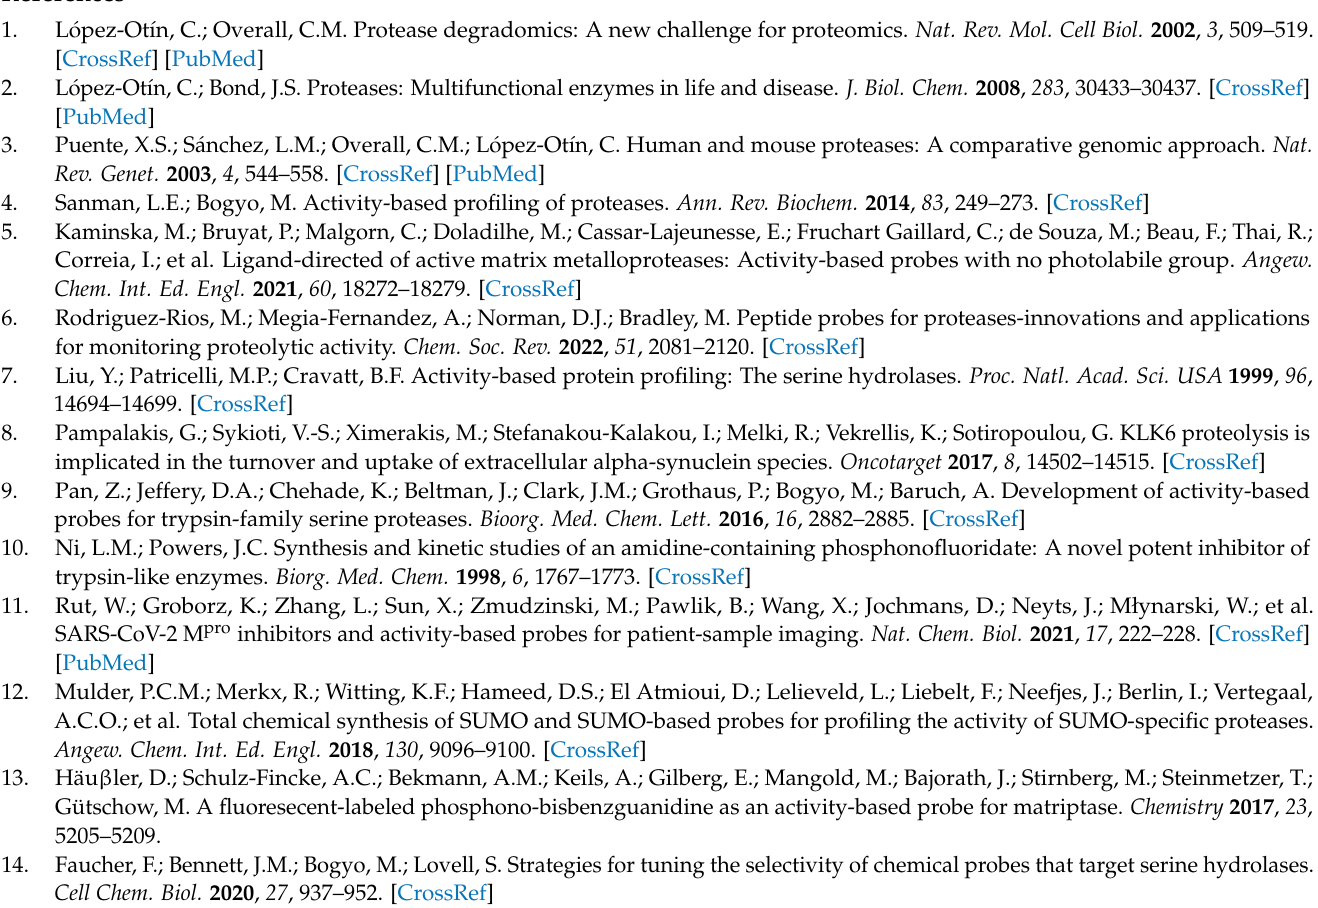
Figure preparation: E.B.; Writing—original draft preparation: G.S. and G.P. All authors have read and agreed to the published version of the